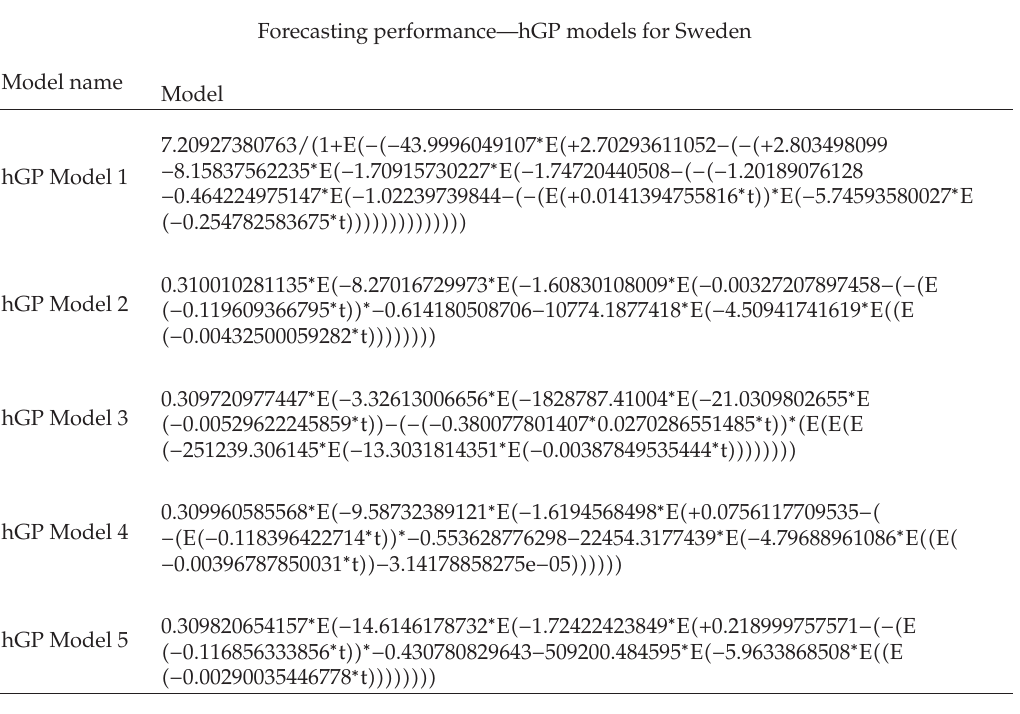
Table 31: Representation of the first five produced hGP models in forecasting (cid:2) Sweden (cid:3) . Forecasting performance—hGP models for Sweden